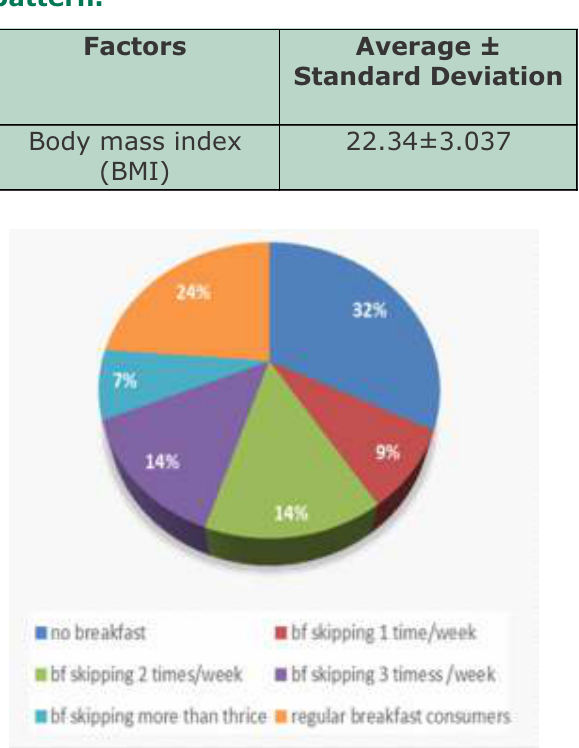
Figure-I: Shows prevalence of breakfast skipping among adolescent university girls. *BF=Breakfast.